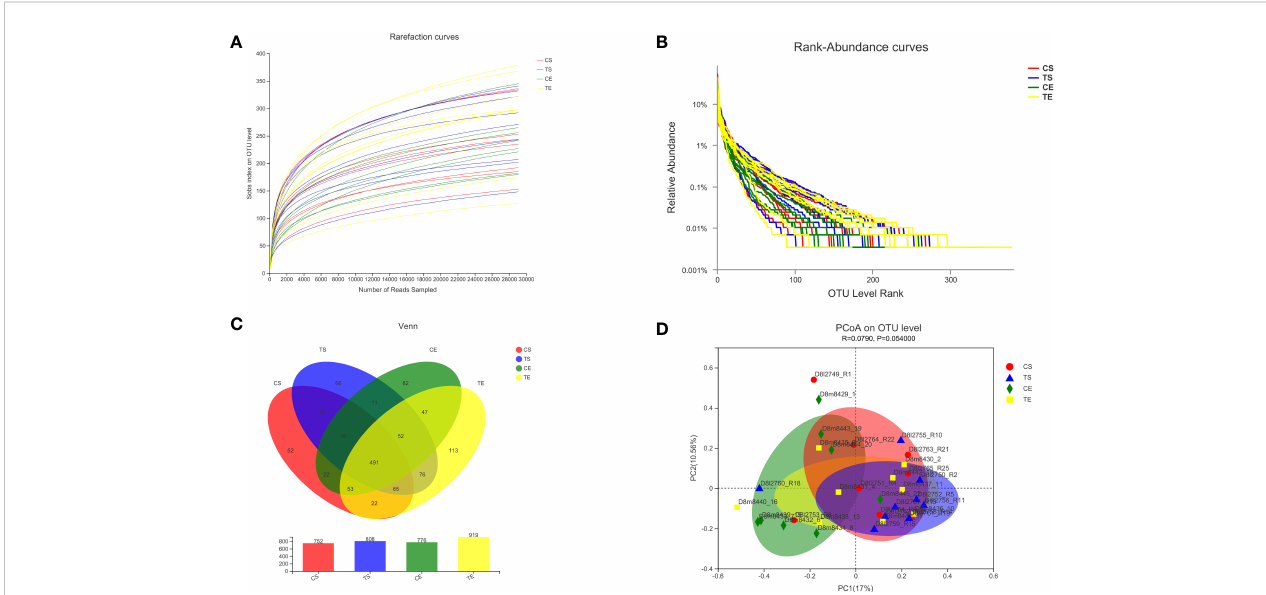
FIGURE 4 The diversities of gut microbiota before and after the high- fi ber diet consumption were analyzed, and the CS and CE groups revealed the start and end phases in the control group, while the TS and TE groups revealed the start and end phases in the treatment group. The rarefaction curves (A) , rank abundance curves (B) , and Venn diagram (C) indicated the alpha diversity of gut microbiota, and the principal coordinate analysis (PCoA) revealed the beta diversity (D)